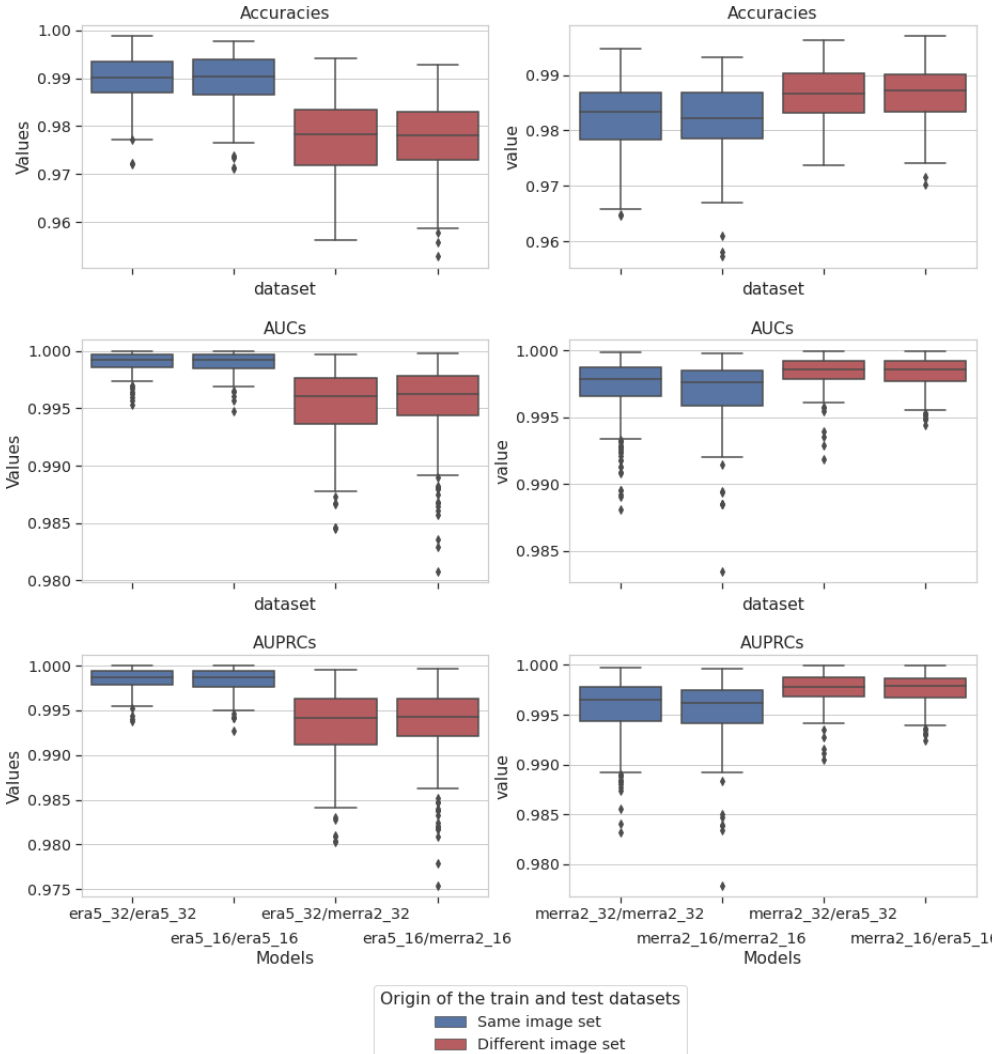
Figure 9. Box plots of the accuracy, the AUC, and the AUPRC metric values for the CNN for different combinations of training and test image sets. In blue, the models are tested against the same image set that they are trained against. In red, the models are tested against the other image set of the same resolution (e.g., era5_32/merra2_32 means the CNN was trained on ERA5 native and tested against MERRA-2